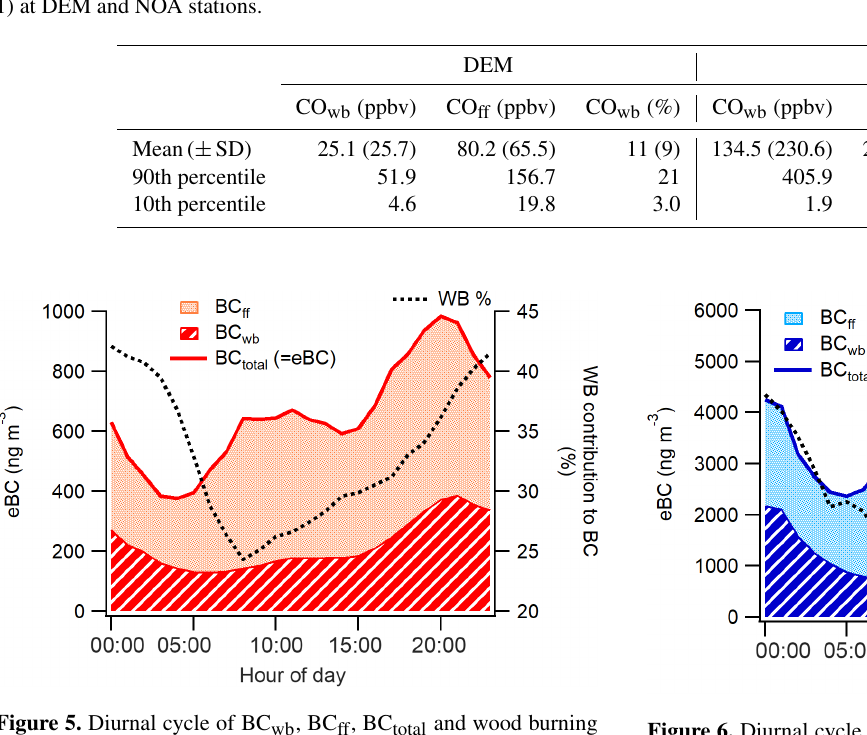
Figure 6. Diurnal cycle of BC wb , BC ff , BC total and wood burning contribution to total BC (WB, defined as C wb / BC total · 100) at NOA